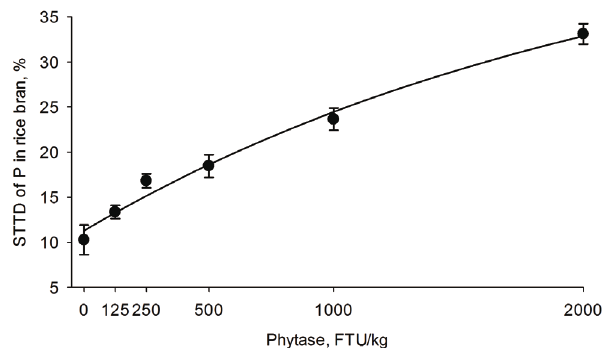
Figure 5. Fitted exponential model of standardized total tract digestibility (STTD) of P in sunflower meal as a function of concentration of exogenous phytase in the diet. Treatment means ( ● ) and standard error are shown. STTD of P =26.441+34.3873×[1–exp(–0.002 ×phytase dose in FTU/kg)], r 2 = 0.99, p<0.001. The concentration of phytase needed to maximize (i.e., to obtain 95% of the upper asymptote) the STTD of P at 57.8% was calculated to be 1,219 FTU/kg. FTU, phytase units.